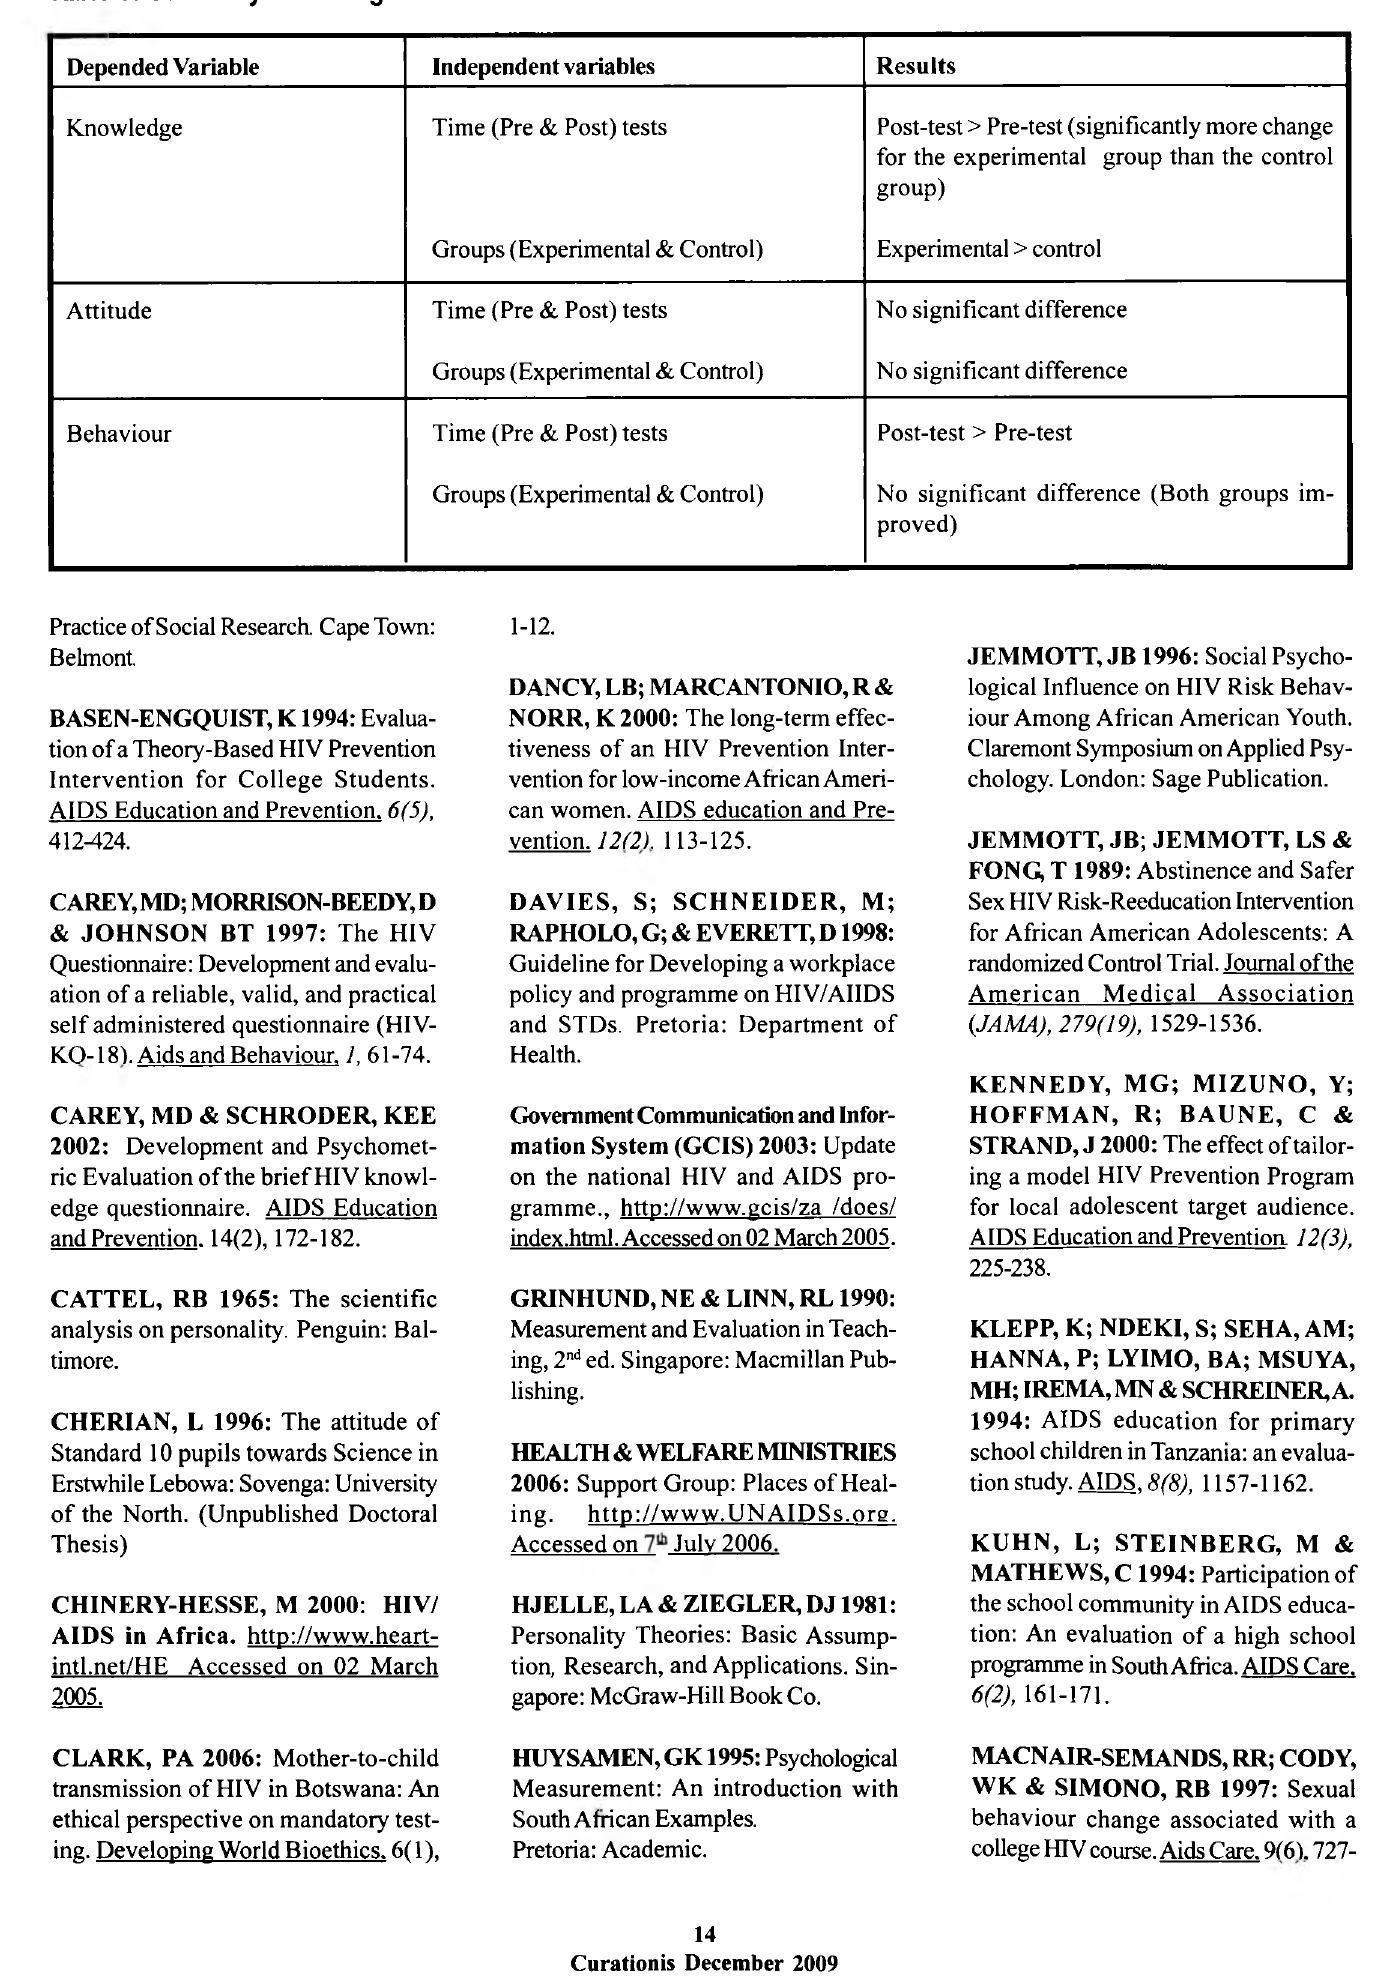
Table 8: Summary of